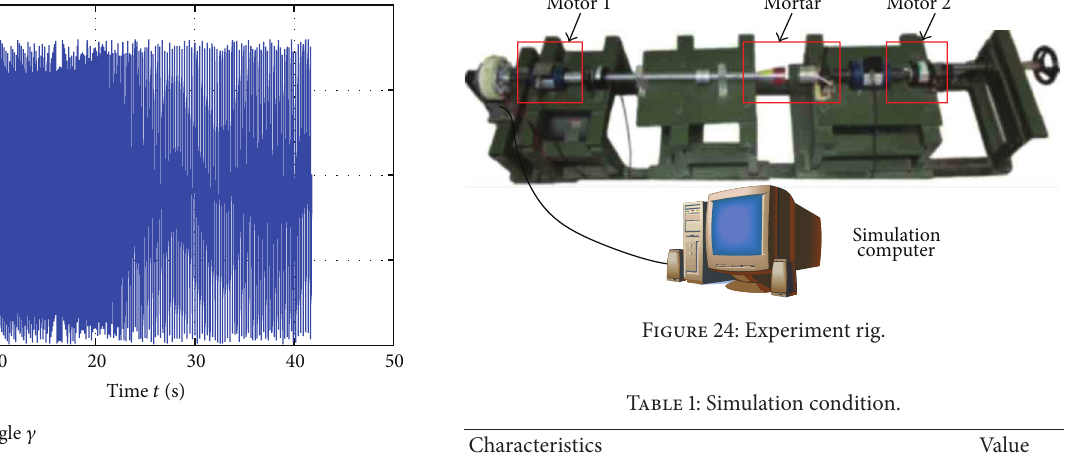
Figure 22: Result of roll angle 𝛾 𝑓 .